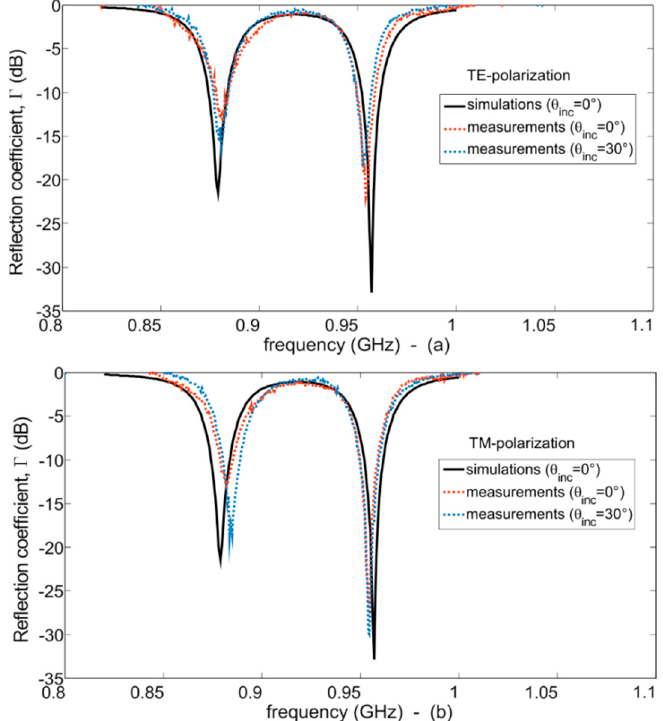
Figure 7. Comparison between measured and simulated reflection coefficients vs frequency: ( a ) TE-polarization; (b) TM-polarization.